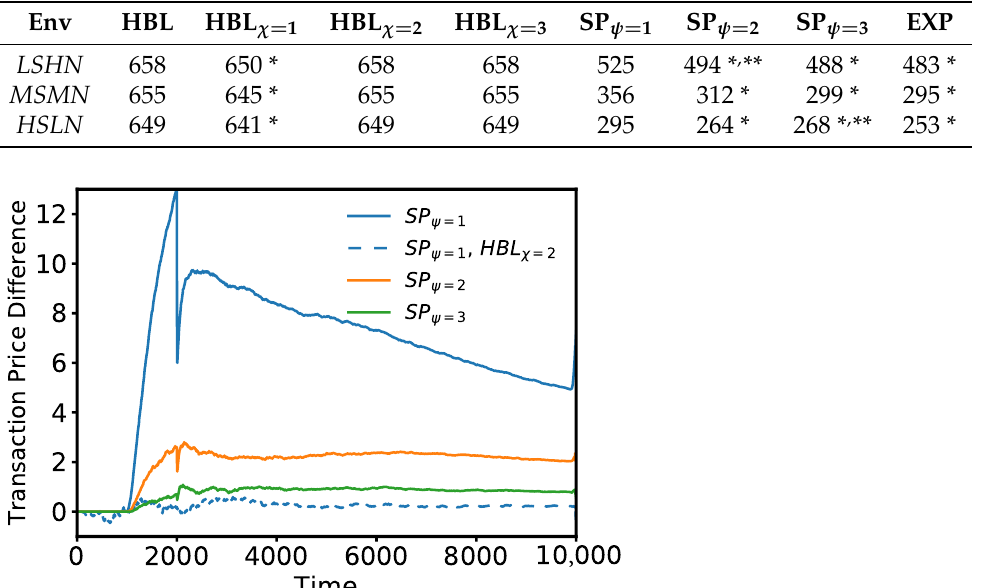
Table 5. Average payoffs of learning-based background traders and the exploiter, as they deviate from the equilibrium strategy profiles found in Section 7.2.1. We deviate either background traders or the exploiter to its corresponding strategy variation. We refer to the exploiter who spoofs as SP and the one who only executes trades as EXP. Asterisks denote statistical significance at the 1% level for the paired t-test in payoffs compared to the standard HBL (*), SP K = 1 (*) and EXP (**).